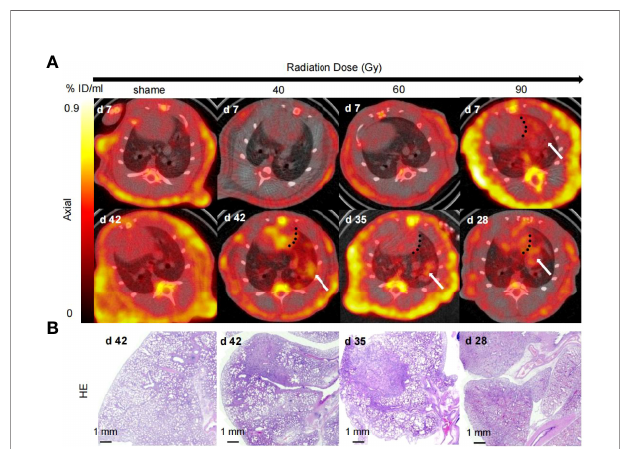
FIGURE 2 | 18 F-NOTA-FAPI PET/CT and pathologic evaluations of rat lung tissues with different radiation doses. (A) Micro-CT imaging of FAPI uptake in irradiated rat lung tissue. The black dotted line separates the uptake of tracer in the lung from that in the heart, and the white arrow indicates the presence of RILD in the lung tissue after radiation. Rats in the 40 Gy and 60 Gy groups showed no RIP and began to show RILF on days 42 and 35 after radiation, respectively. In contrast, rats in 90 Gy group showed 18 F-NOTA-FAPI uptake in areas of RIP on day 7, with reappearance of tracer uptake in the irradiated area on day 28 after radiation. (B) Representative micrographs of HE-stained lung sections from the 40 Gy, 60 Gy, and 90 Gy groups at days 42, 35, and 28, respectively, showed that the radiation damage was con fi ned to a small area.